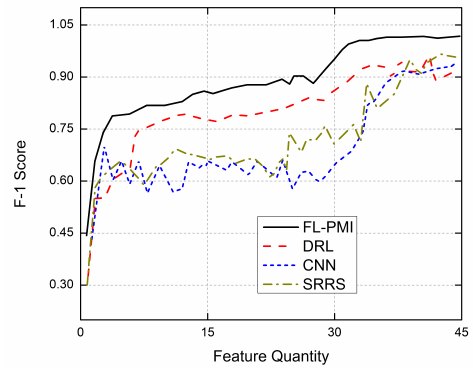
Figure 7. F1-score analysis for varying feature quantities.